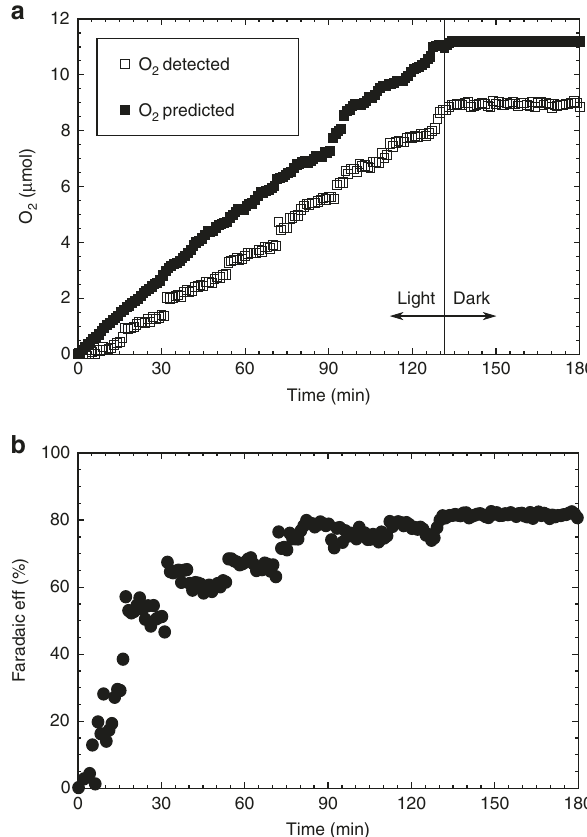
Fig. 8 O 2 evolution performance on TiO 2 |CsPbBr 3 |m-c|GS|WOC. a Detected (open square) and predicted (close square) O 2 production under continuous simulated solar light irradiation (AM 1.5G, 100mWcm − 2 ),